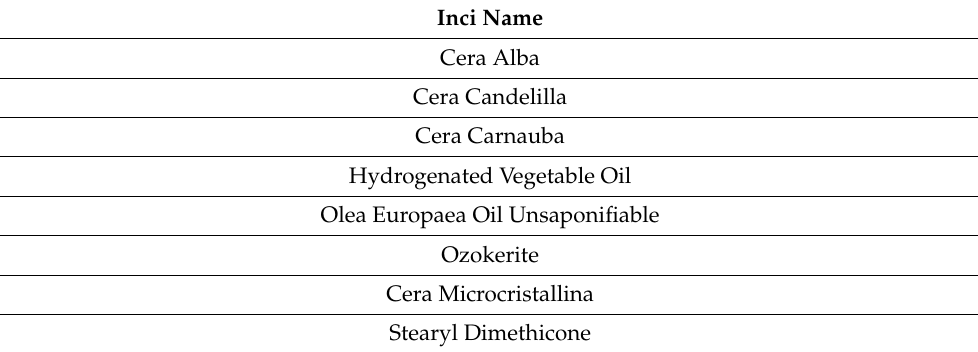
Table 3. Waxes commonly used in